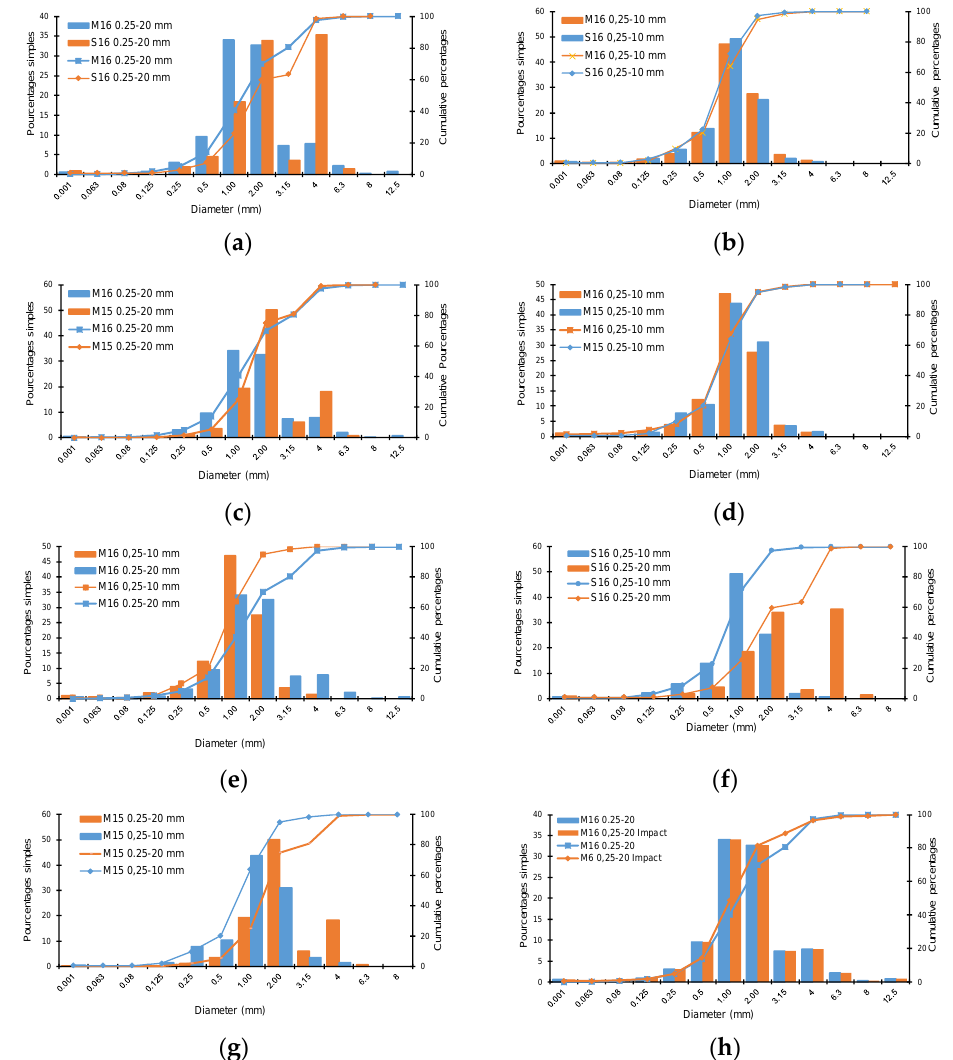
Figure 8. Mechanical sieving results for rapeseed straws: ( a , b ) — the climates of Marne and Somme, ( c , d ) — the years of harvest, ( e , f ) — the size of aggregates, ( g , h ) — the type of gridding. Table 3. Particle size distribution of rapeseed